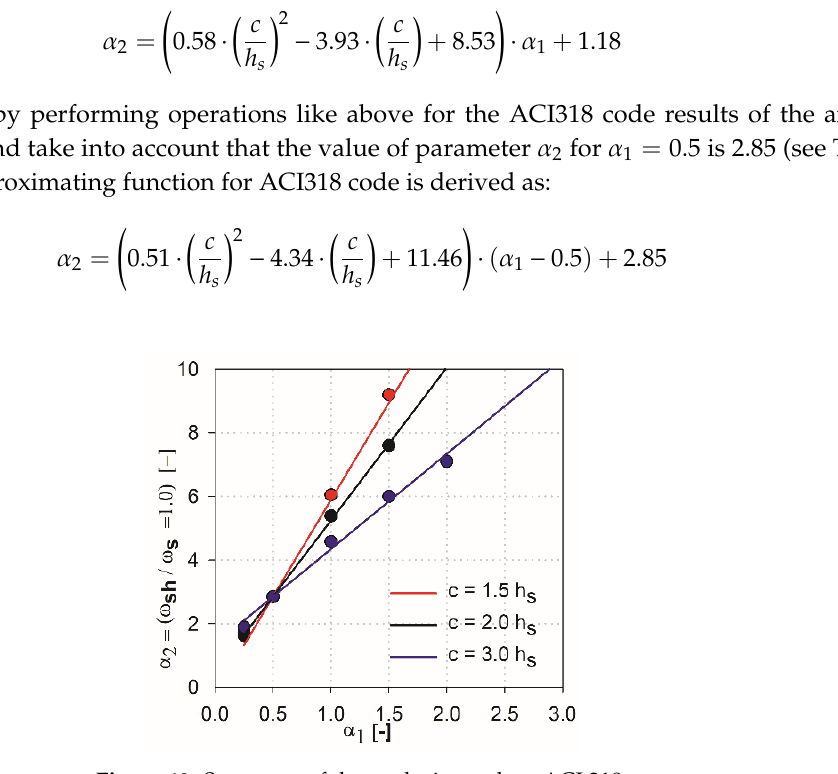
Figure 12. Summary of the analysis results—ACI 318.